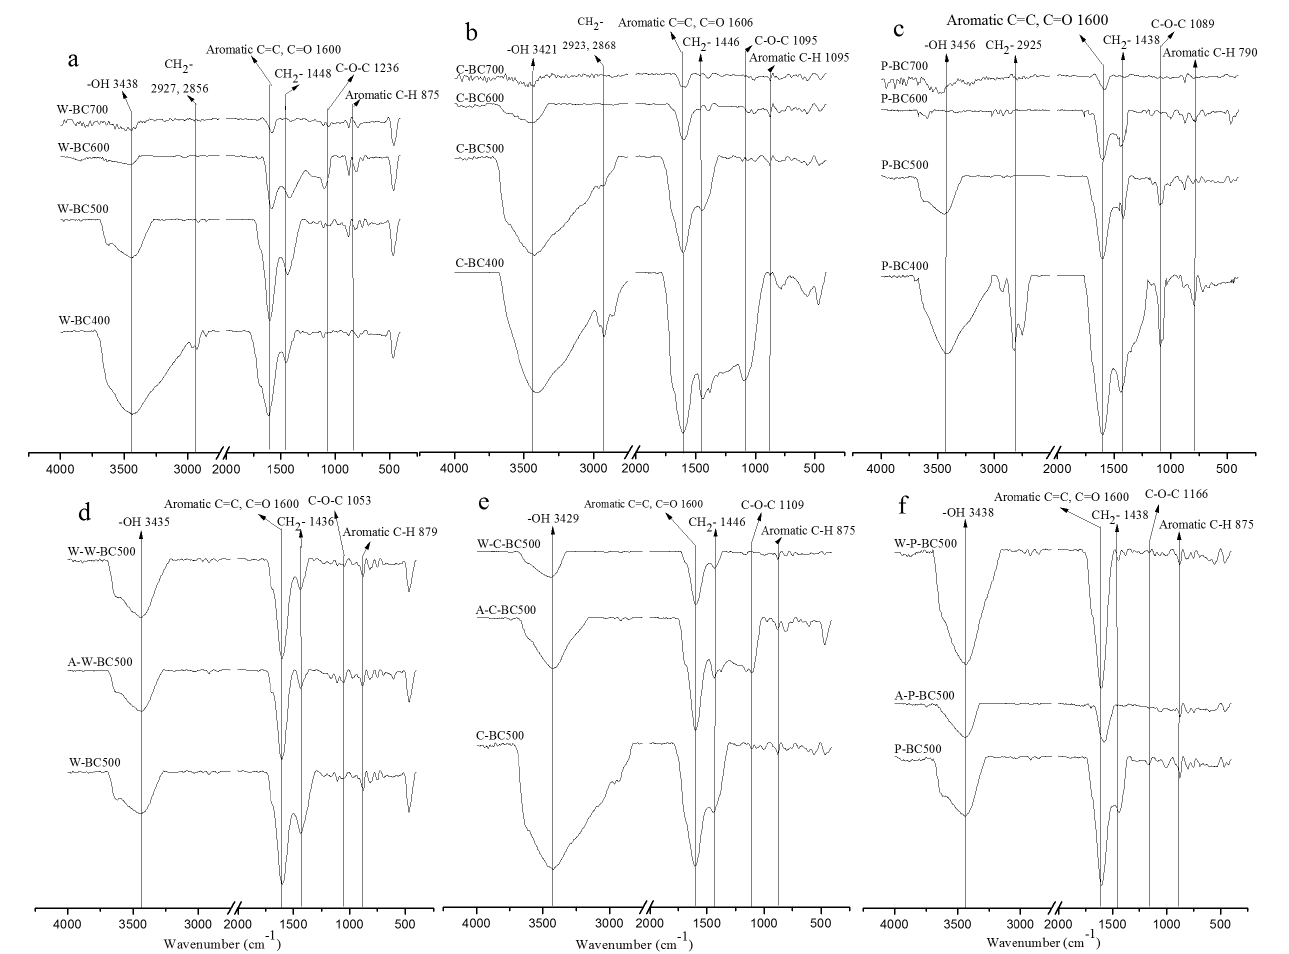
Figure 1. FT-IR spectrum of wheat-straw biochar (W-BC), corn-straw biochar (C-BC) and peanut-shell biochar (P-BC) at different pyrolytic temperatures and the biochars with different treatments at 500 ˚ C (a: W-BC, b: C-BC, c: P-BC, d: W-BC500 with acid- and DI water-washed treatments, e: C-BC500 with acid- and DI water-washed treatments, f: P-BC500 with acid- and DI water-washed treatments).